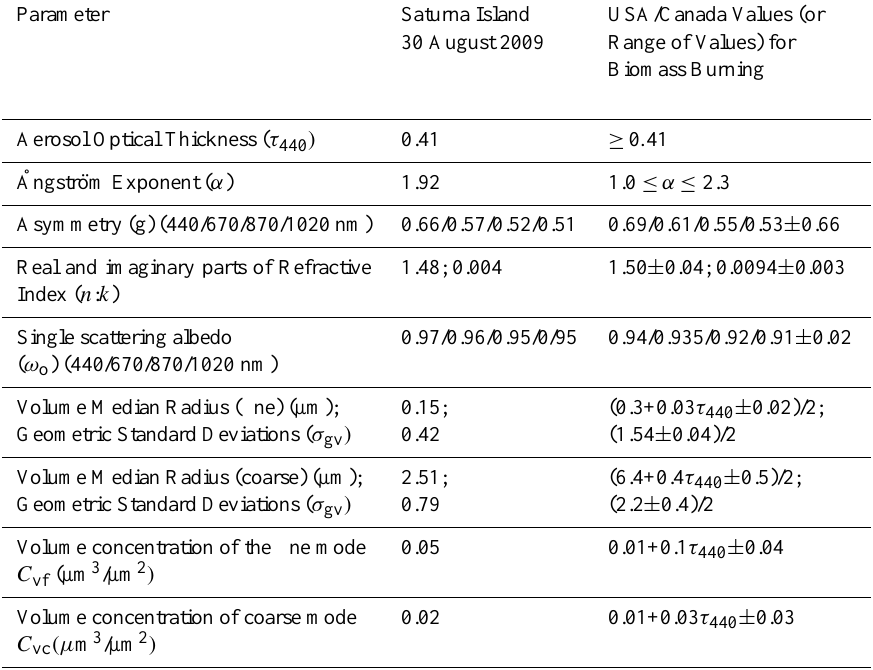
Table 1. Summary Comparison of AERONET daily values for 30 August 2009 at Saturna Island and biomass burning aerosol optical properties from Reid et al. (2005a) summary (Table 3) of worldwide AERONET network of ground-based radiometers. In the right column are boreal forest biomass burning properties from USA and Canada. The middle column shows AERONET daily values for 30 August